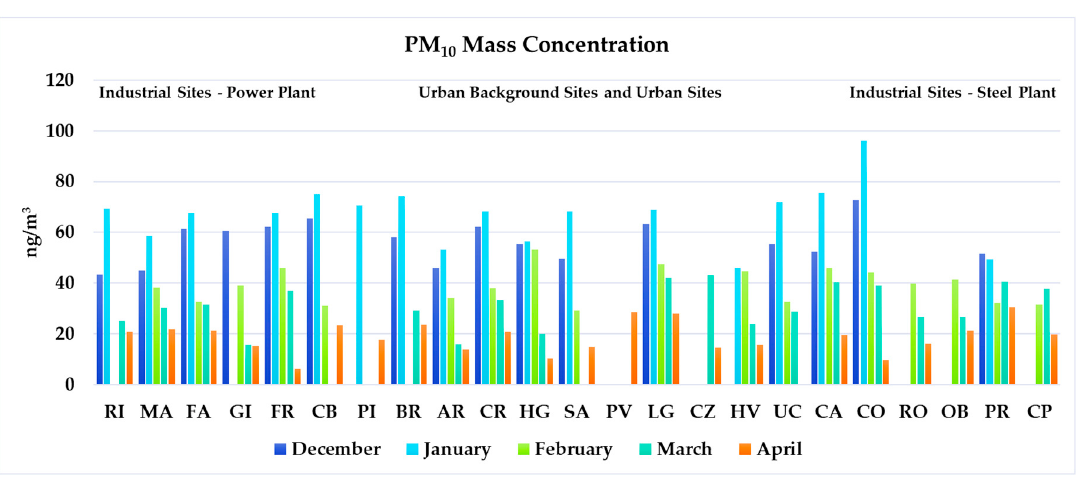
Figure 3. PM 10 mass concentrations ( μ g/m 3 ) recorded at the 23 collection sites during the five-month monitoring campaign.